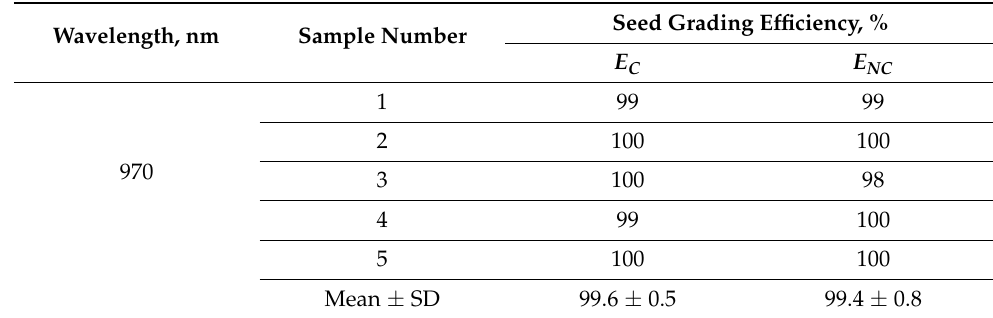
Table 3. Preliminary detection options for the choice of a plan center for Scots pine seeds’ grading using a spectrometric feature in the near-infrared-wavelength region (amplitude A 0 = 60). Wavelength,